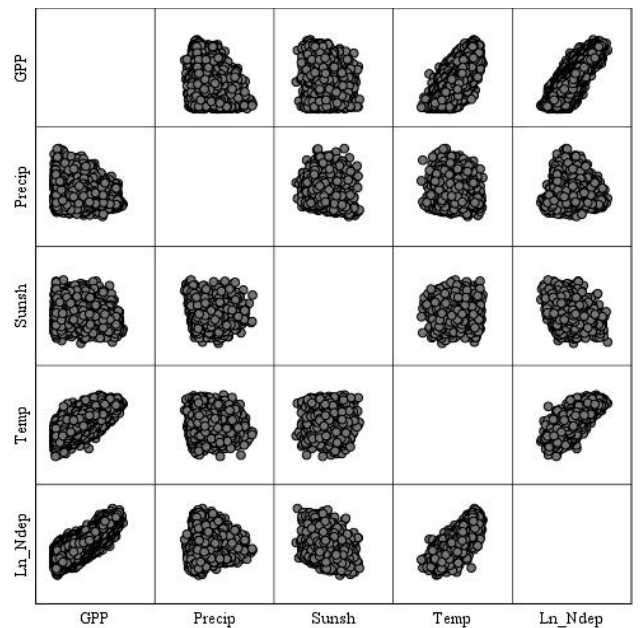
Figure A7. Correlation matrix using the natural logarithm of N deposition for the class grasslands and the year 2000.